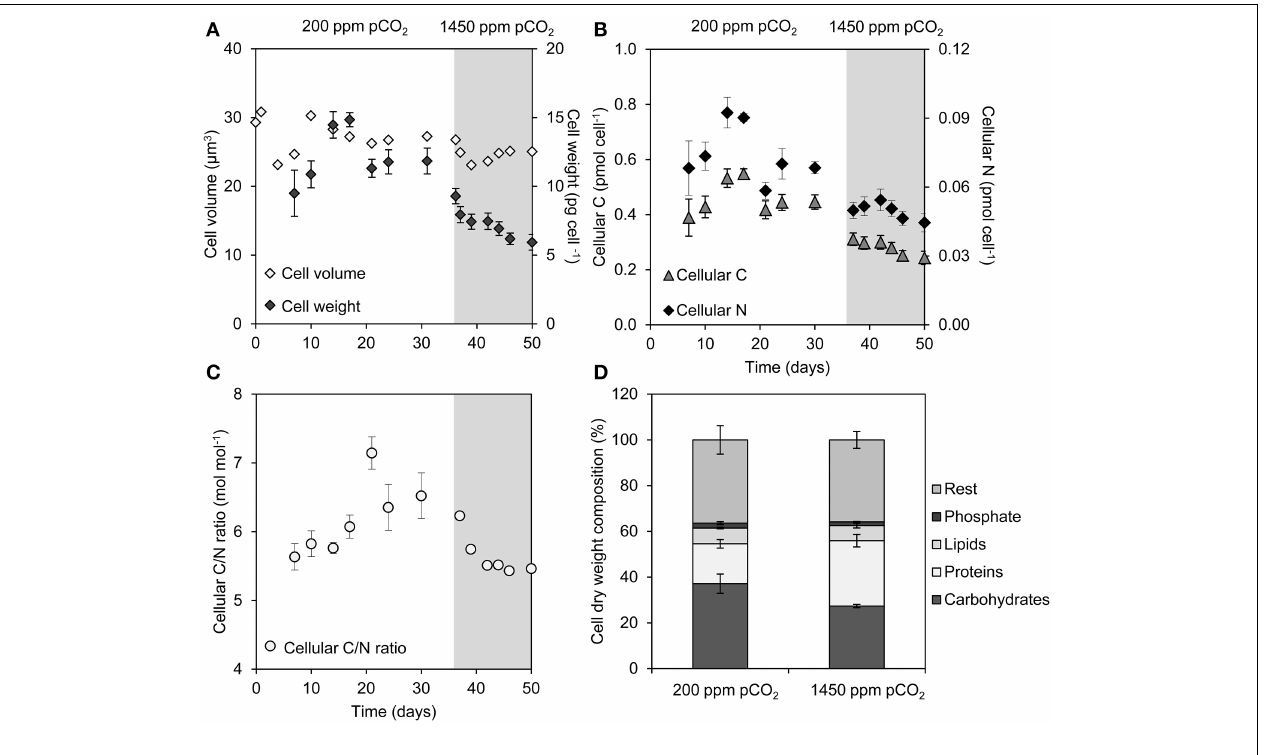
(C) Molar C/N ratio of the cells. (D) Dry weight composition of cells from the steady states at 200 and 1450ppm pCO 2 . Error bars indicate standard deviations ( n = 4